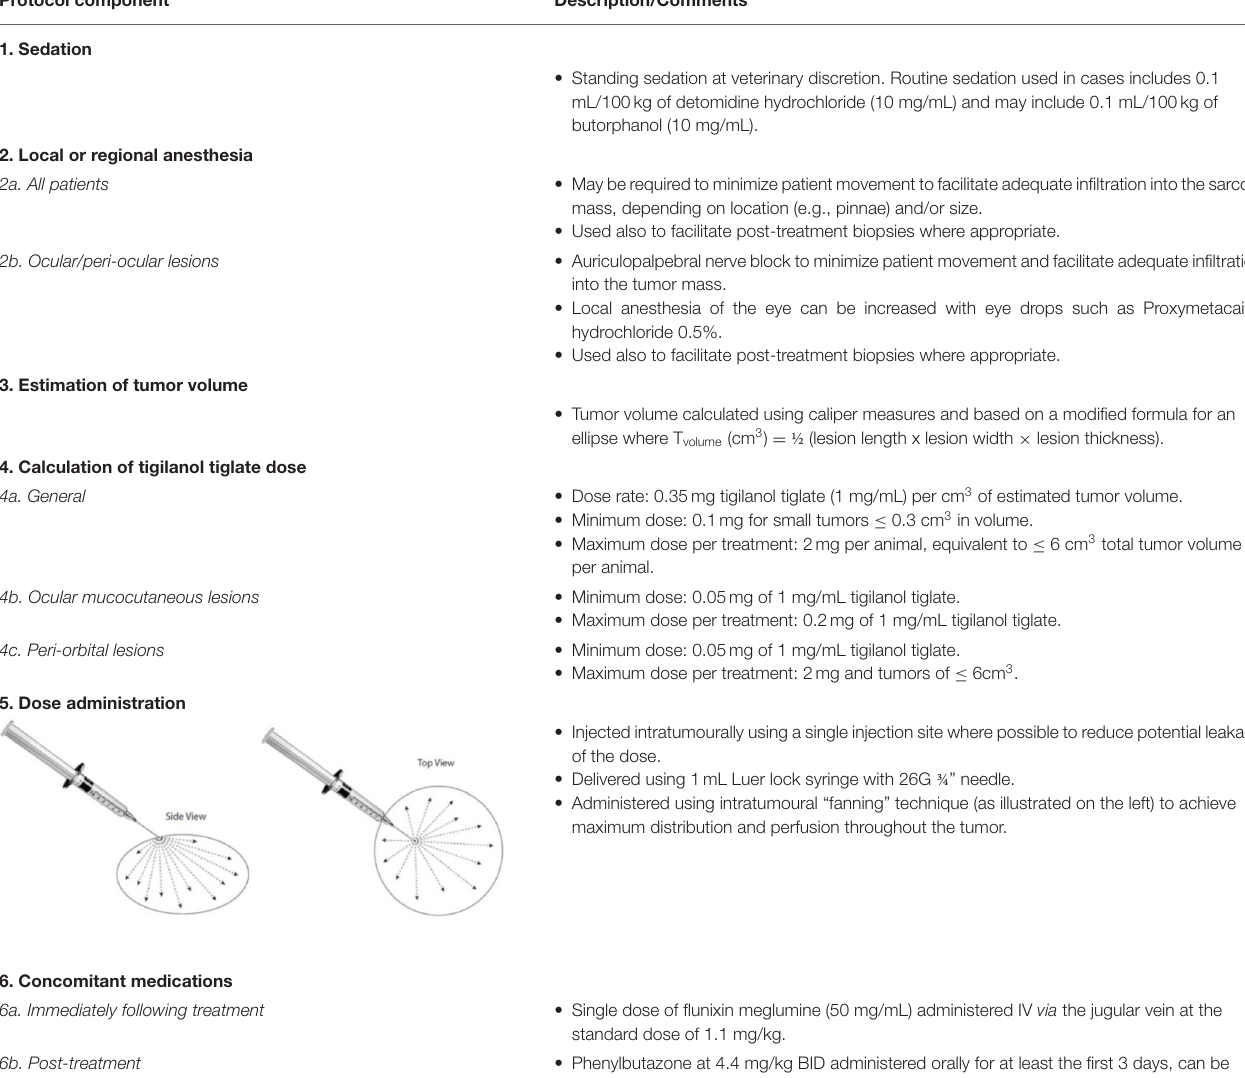
TABLE 1 | Overview of tigilanol tiglate treatment protocol under development for equine sarcoids and squamous cell carcinomas, including ocular and peri-ocular lesions. Protocol